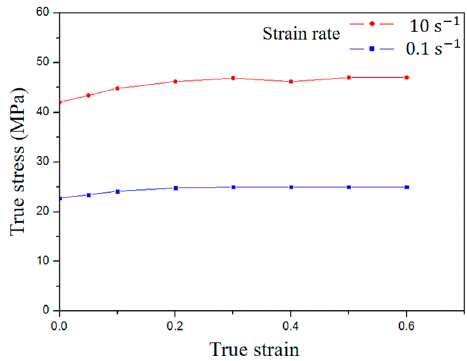
Figure 3. Flow curves of Al6061 at 450 °C for strain rate 0.1 s − 1 and 10 s − 1 .